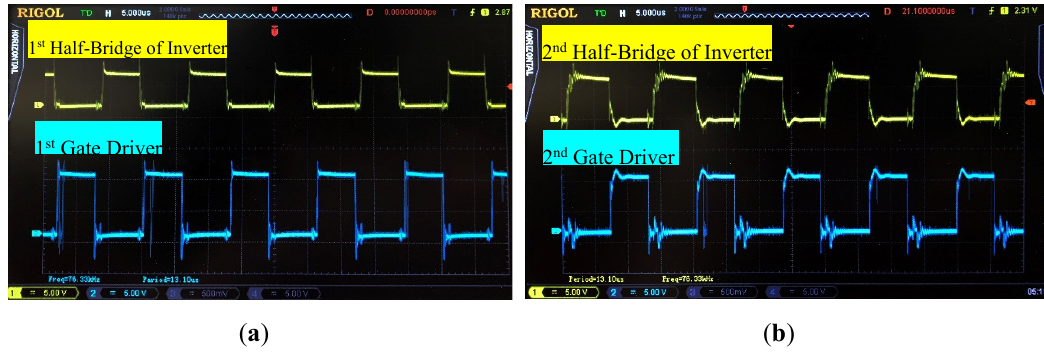
Figure 13. (a) 1st and ( b ) 2nd half-bridge outputs of GaN inverters, controlled by their respective gate drivers.